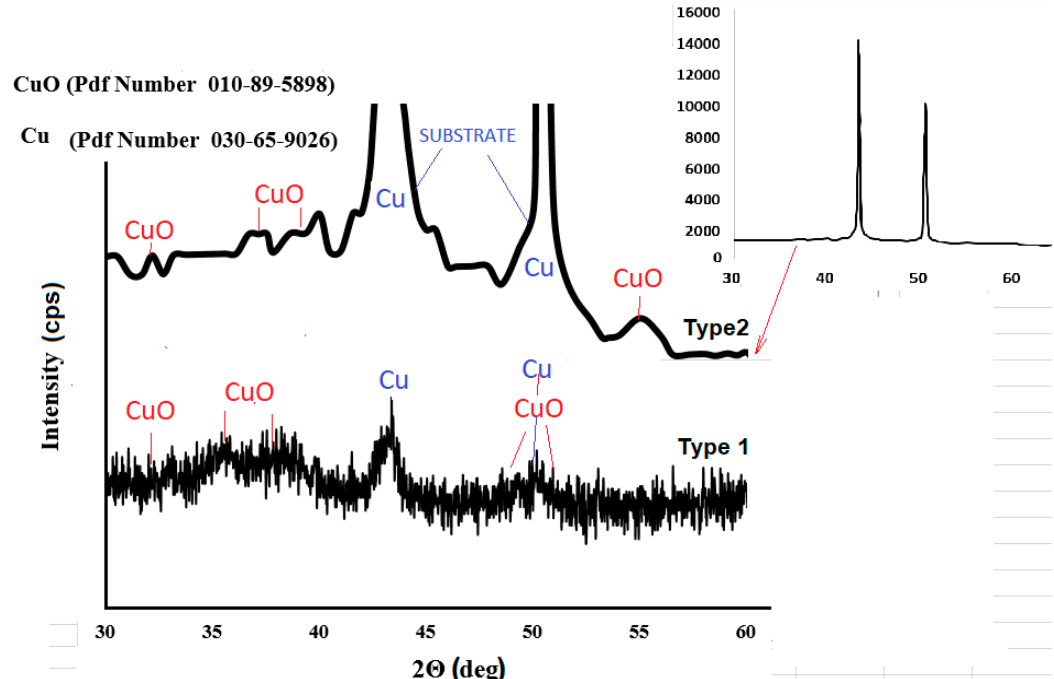
Figure 4. XRD of silicon–carbon films, doped with copper.